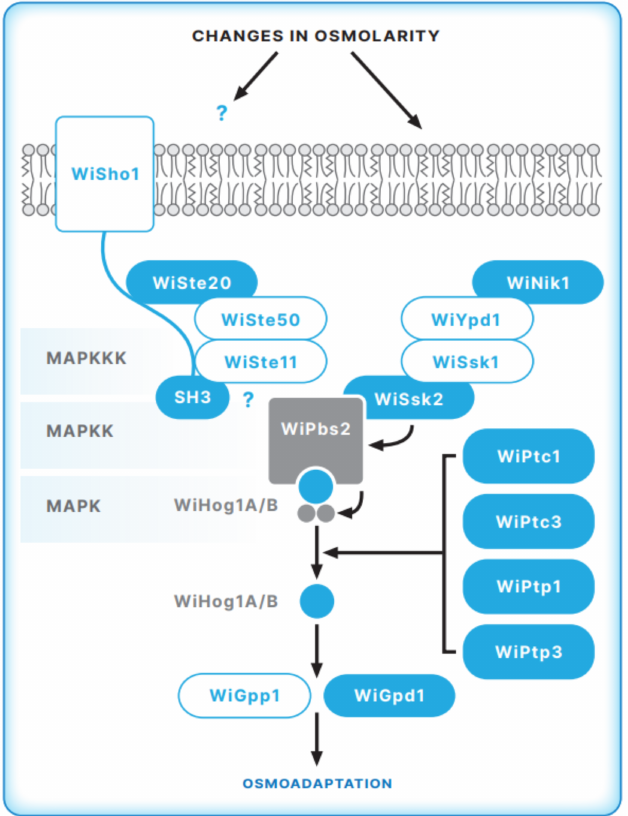
Figure 2. Model of the HOG pathway architecture in W. ichthyophaga . Putative HOG-pathway components identified in the genome of W. ichthyophaga are shown. WiSho1, WiSte11, WiPbs2, and WiHog1 proteins were characterized in detail as summarized in the text. Identified target genes of WiHog1, WiGpp1, and WiGpd1are shown. (Illustration made by Matej